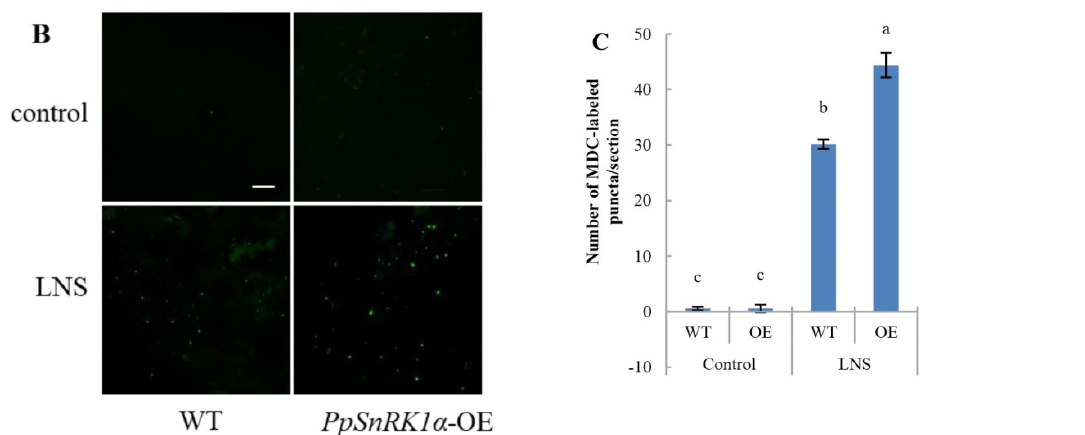
Figure 3. Effects of PpSnRK1 α overexpression on autophagy activity in WT and OE leaves under 7 days of LNS. ( A ) Changes in the transcription levels of tomato ATGs in the WT and OE lines. ( B ) Autophagosomes by MDC staining in leaves of WT and OE plants. Autophagosomes by MDC staining are shown as green signals. Bars: 50 μ m. ( C ) The number of autophagosomes by MDC staining per image in ( B ) was quantified to calculate the autophagic activity. Different lowercase letters indicate significant differences according to Duncan’s multiple range test ( p <